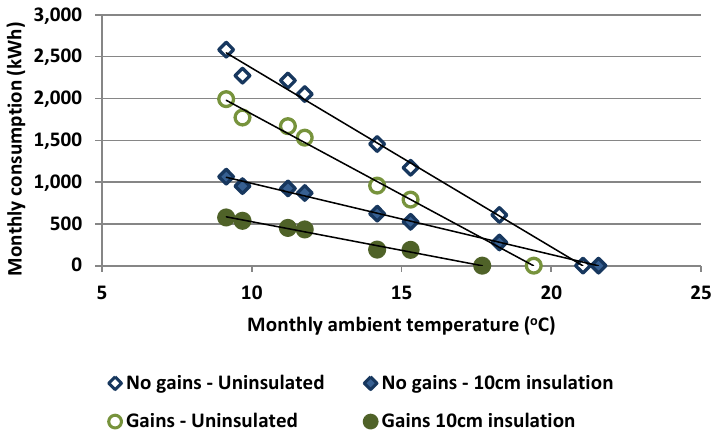
Figure 1. Correlation of consumption to the mean monthly ambient temperature, to demonstrate the effect of insulation and heat gains on the balance temperature.